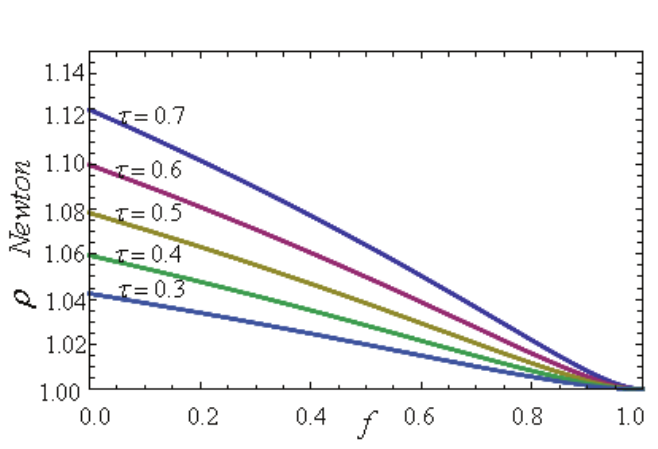
Figure 9. Comparison between the quotients law for several values of τ